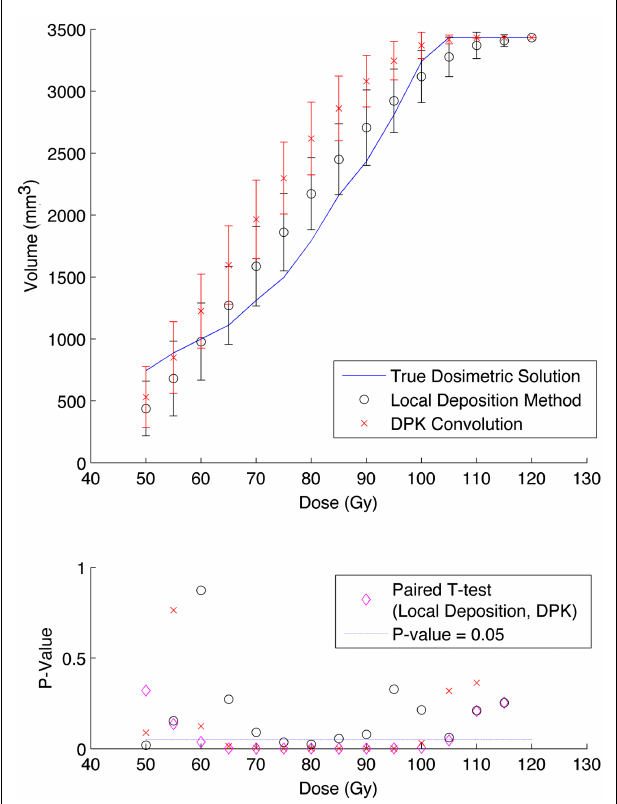
FIGURE 4 |Top: IDVH of NEMA phantom 37mm hot-sphere comparing DPK convolution and the local deposition method, as determined from 8, 20min scans according to recon 1 inTable 1 . Reconstruction was performed using 4mm isotropic voxels with 1 iteration, 21 subsets, and TOF. Both experimental IDVH are compared to the true dosimetric solution IDVH. Bottom: error analysis.